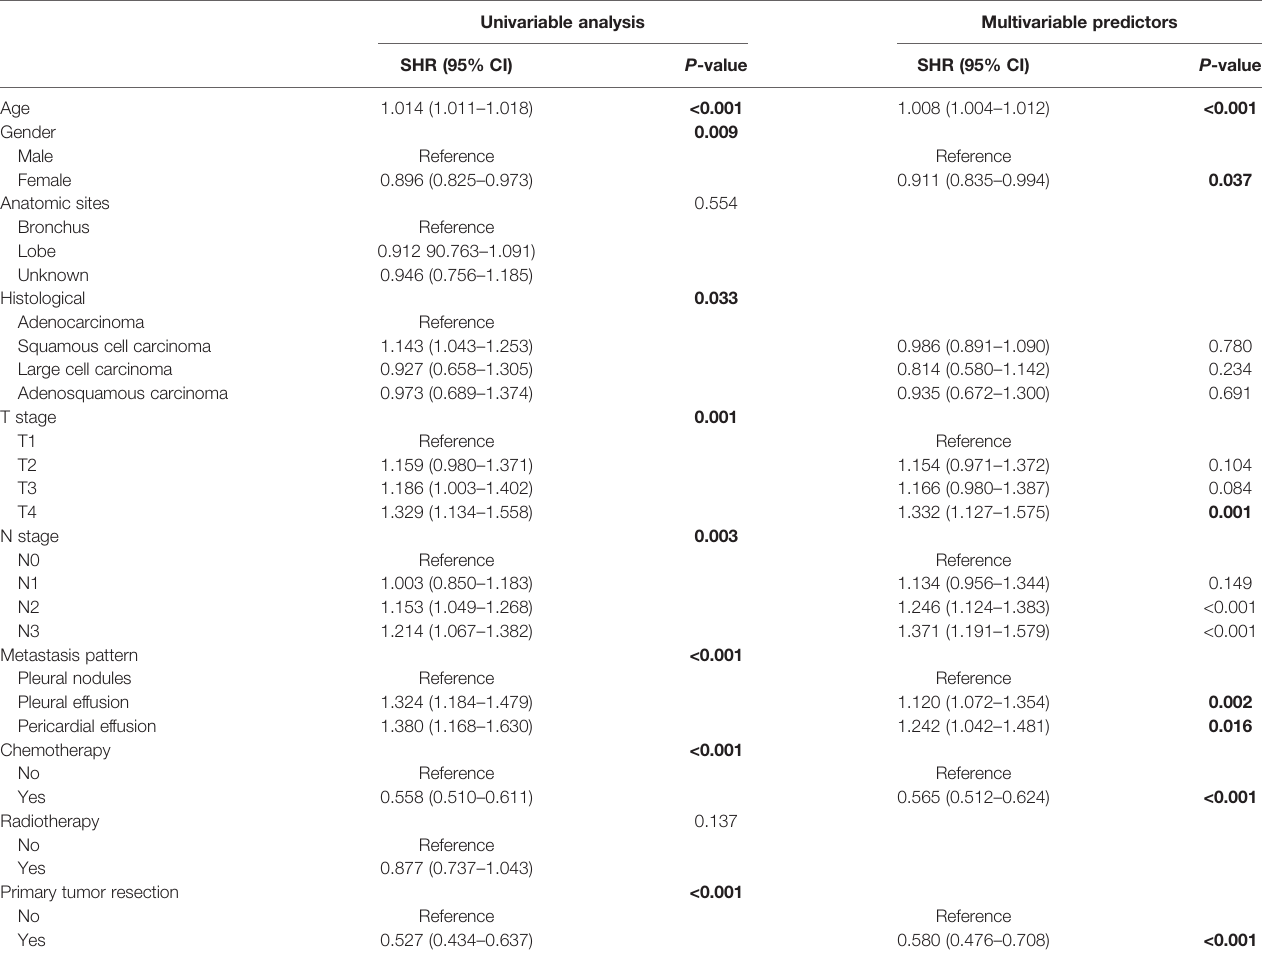
TABLE 2 | Univariable and multivariable analyses of the ability of each factor in predicting LCSS in the training